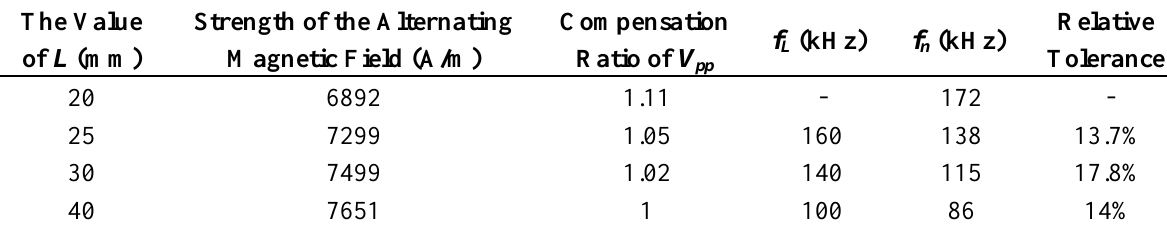
Table 1. The compensation ratio of V f for different L n